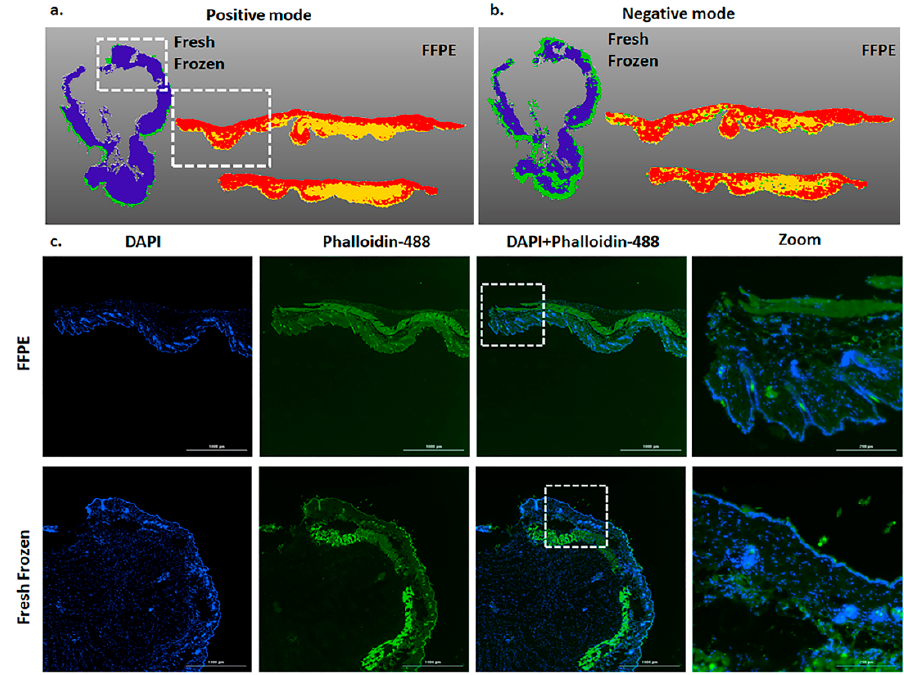
Figure 3. Segmentation and Immunohistochemistry of skin tissue post-MALDI Imaging: ( a , b ) Representative images show the differential presence of metabolites from the skin tissue in FFPE and fresh frozen conditions in positive and negative mode MALDI imaging, respectively. (White dotted box represents the tissue area imaged in ©). ( c ) Representative immunohistochemistry images show the FFPE and fresh frozen tissue sections stained with Phalloidin-488 (green staining actin) and DAPI (blue staining nucleus) stains. The white dotted box shows the zoomed image.